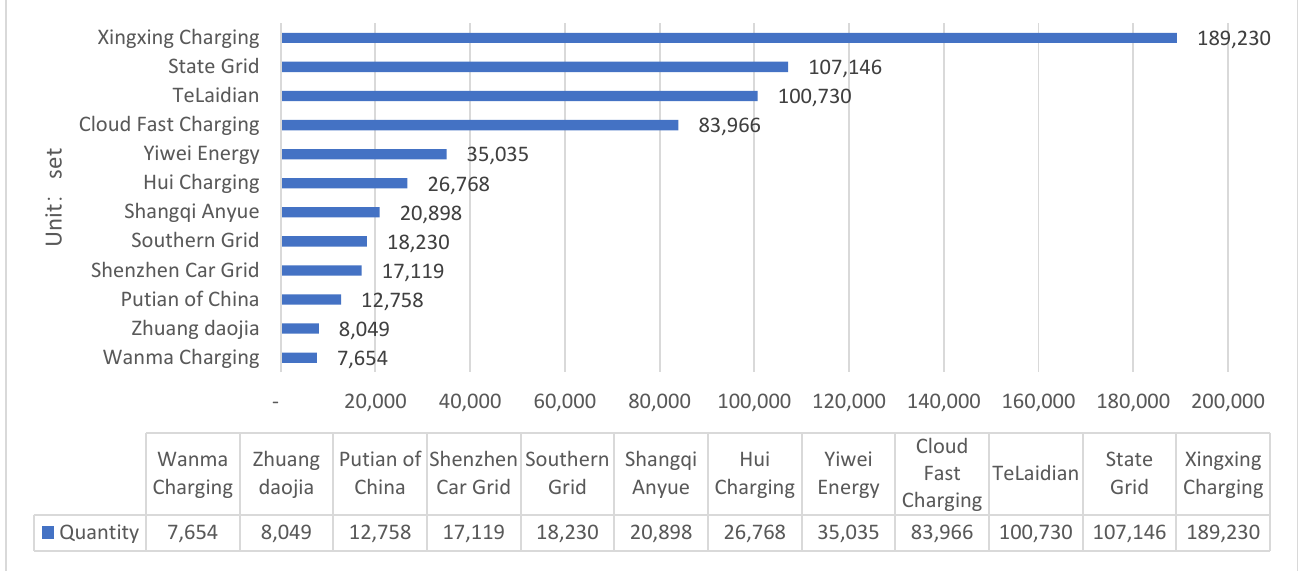
Figure 4. Ranking the market share of charging pile operators in China in 2021. Data source: Pub- lic policy documents of the government